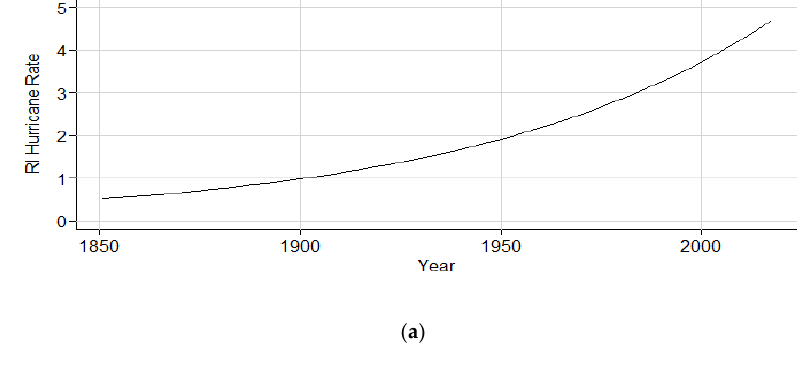
Table 5. Coefficient estimates, p-values, and chi-square p-values on the residual deviance for RI storms originating within the North Atlantic sub-basin.